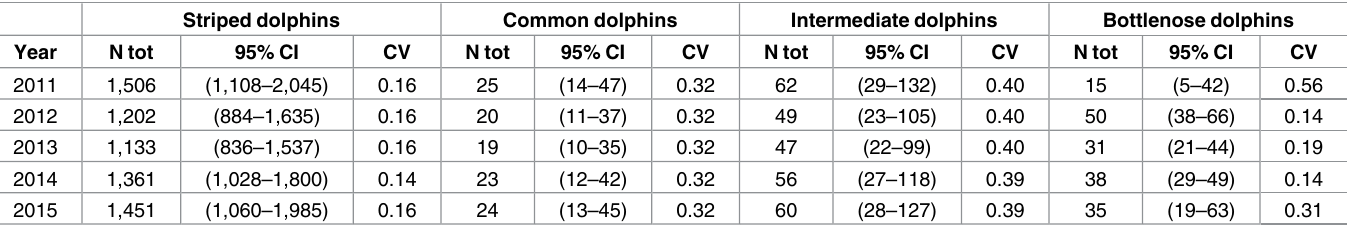
Table 7. Total abundance estimate(N tot) and 95% CI for the three species and intermediate animals. Striped dolphins Common dolphins Intermediate dolphins Bottlenose